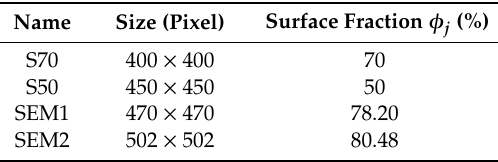
Table 1. Characteristics of the four images used.